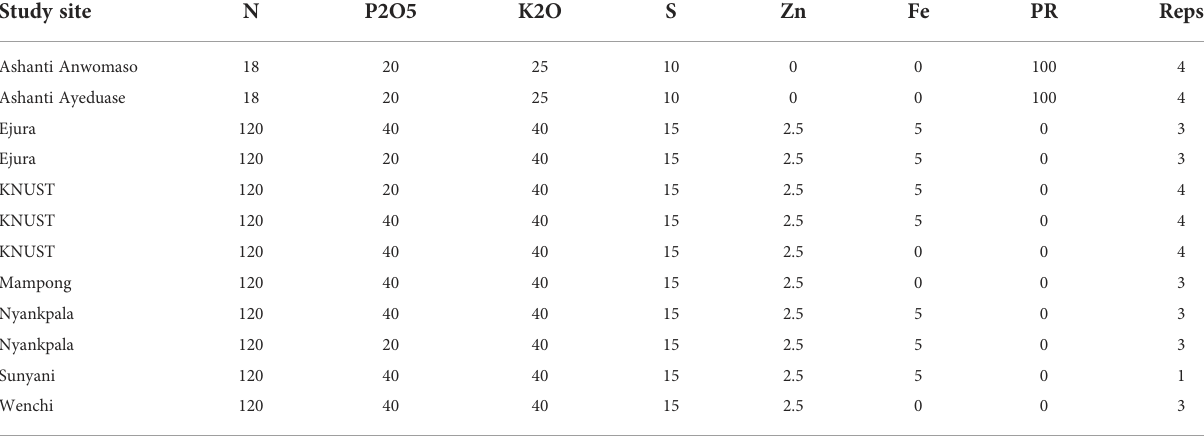
TABLE 2 Fertilizer application rates (kg ha -1 ) at the study sites. Study site